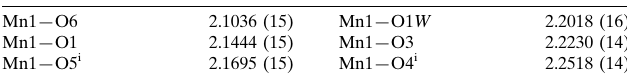
Selected bond lengths (A˚ ).